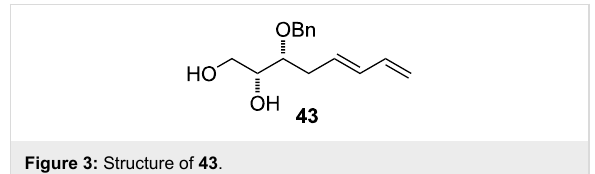
Figure 3: Structure of 43 .